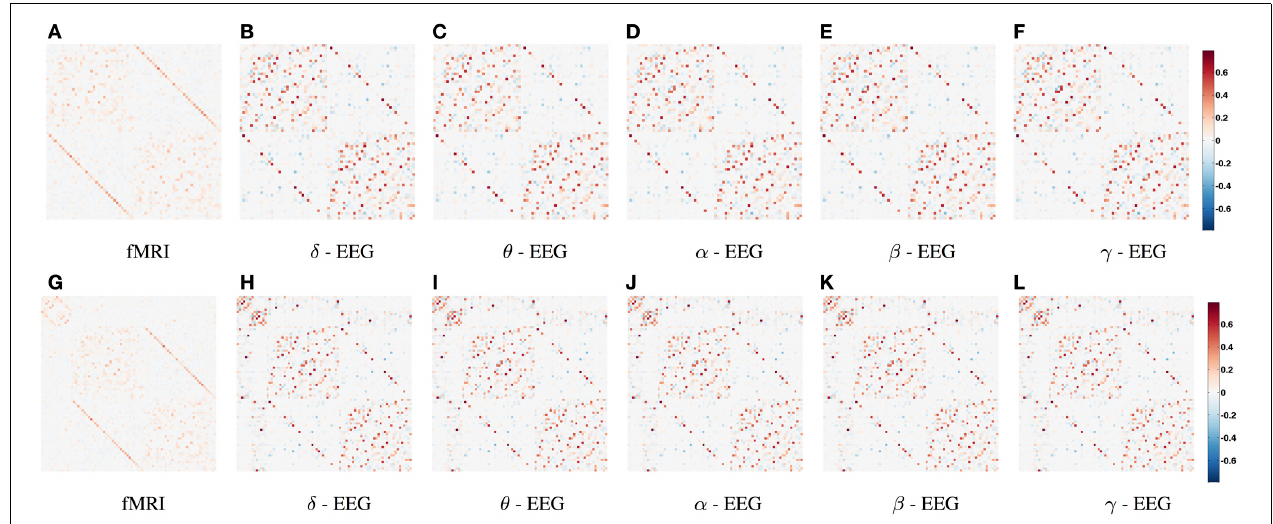
FIGURE 2 | Average functional connectivity matrices across subjects in fMRI and EEG δ , θ , α , β , and γ bands, respectively. In both fMRI and EEG, the precision matrix has been estimated across the whole time samples (WTS). (A–F) Depicts the partial correlation within cortical regions (68 × 68), whereas the bottom row demonstrates the partial correlation within cortical and subcortical regions (82 × 82). (The regions are given in Table S1 and they